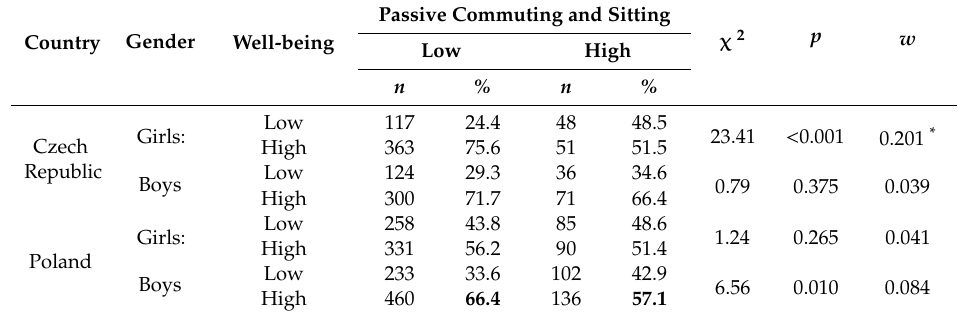
Table3. Theassociationsbetweensedentarybehaviours(passivecommutingandsitting)andwell-being.